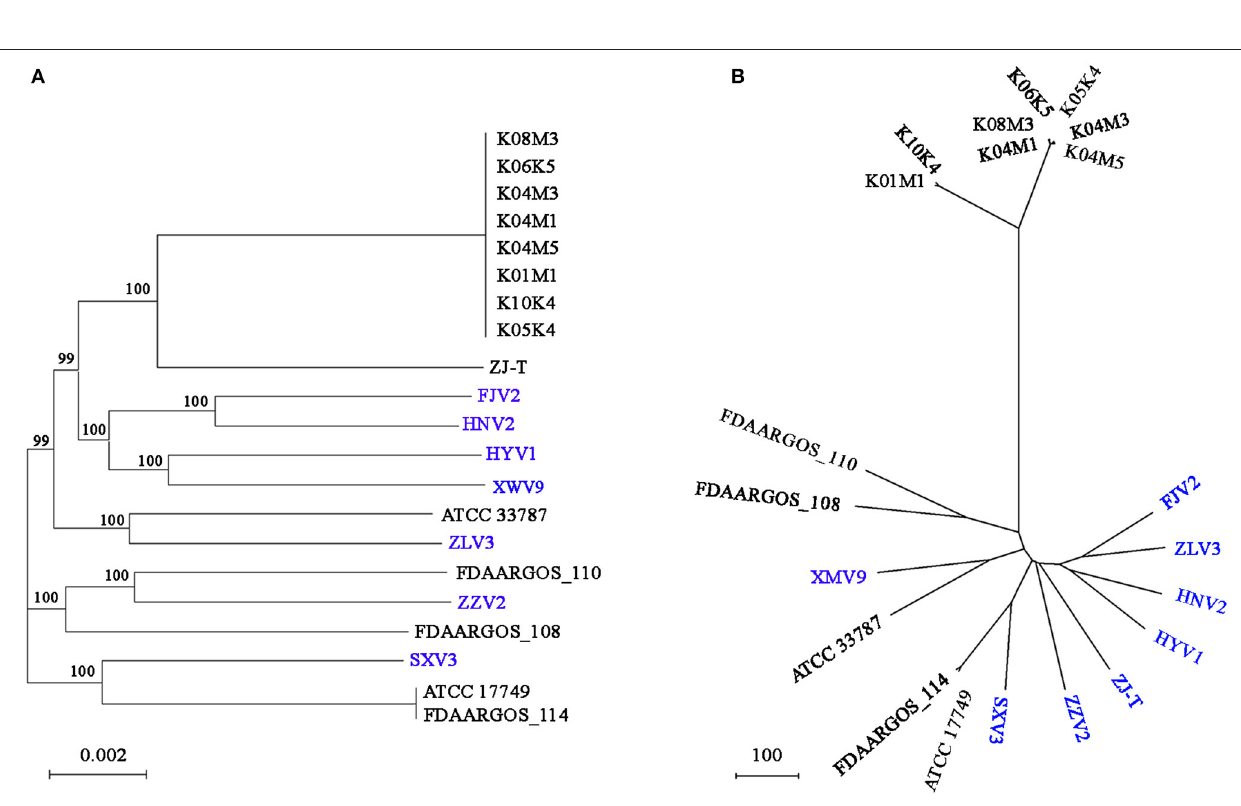
Frontiers in Microbiology | www.frontiersin.org 8 July 2022 | Volume 13 | Article